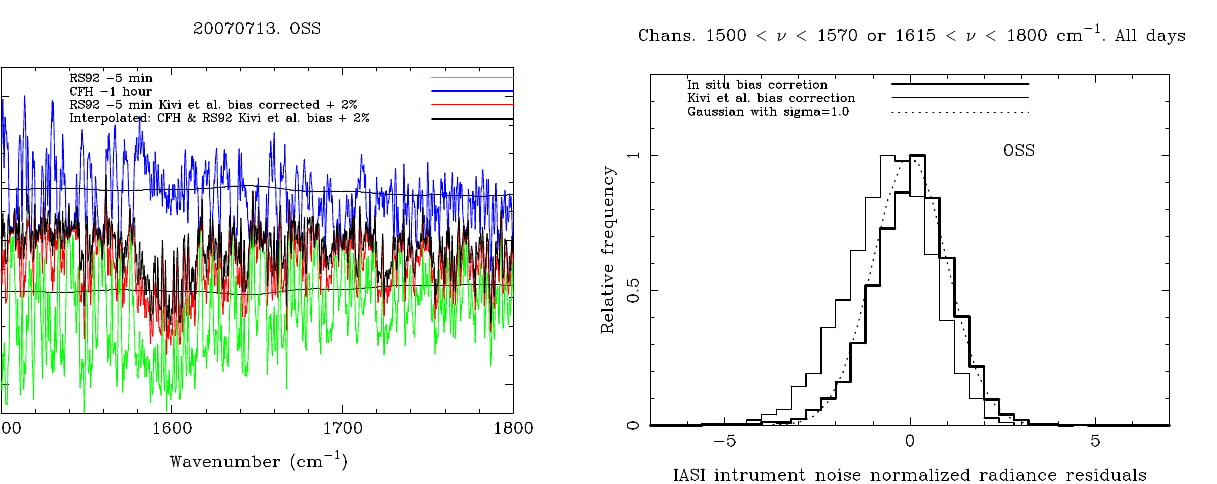
Fig. 9. Histogram of the residual radiances, IASI observed minus calculated with OSS RTM and time interpolated profiles, for all clear days (4) in the spectral range, 1500cm − 1 ≤ ν ≤ 1570cm − 1 and 1615cm − 1 ≤ ν ≤ 1800cm − 1 . One set of interpolated profiles have been derived from the CFH sonde launched 1h before IASI overpass and the “in situ” bias corrected RS92 sonde launched 5min before satellite overpass (thick solid line). The other set of interpo- lated profiles have been derived from the CFH sonde launched 1h before IASI overpass and the Kivi et al. bias corrected RS92 sonde launched 5min before satellite overpass (thin solid line). For refer- ence, a Gaussian curve with a σ of 1.0 is shown (dotted